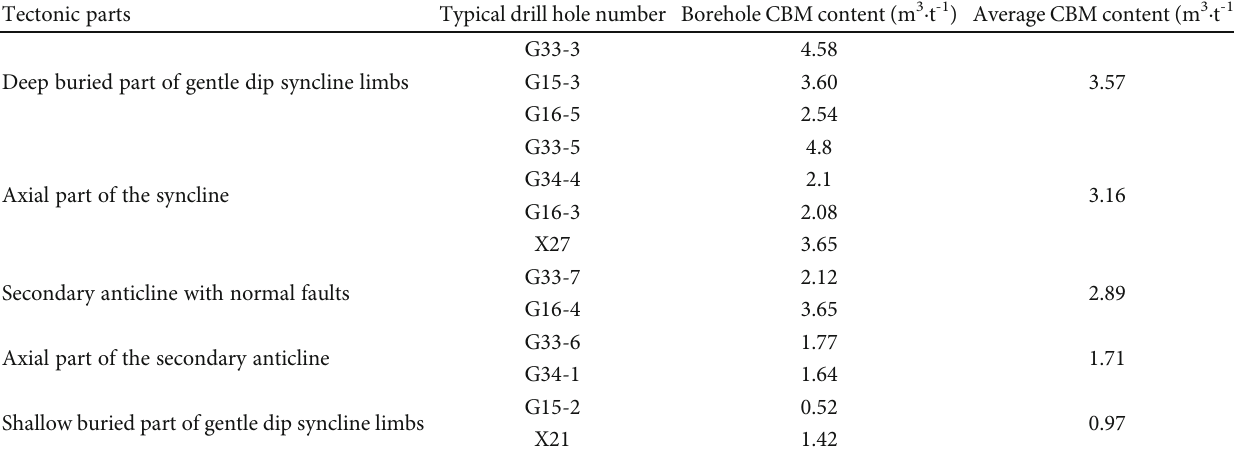
Table 1: Gas-bearing characteristic of coal seams in di ff erent tectonic parts of the Guojiahe well fi eld. Tectonic parts